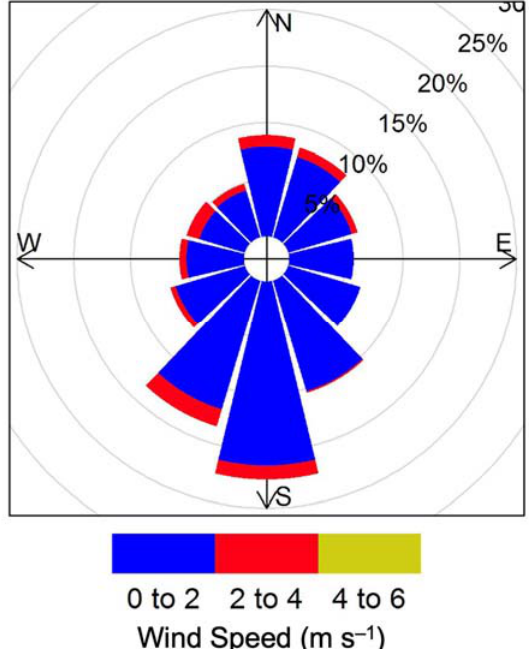
Figure 3. The annual wind rose at the